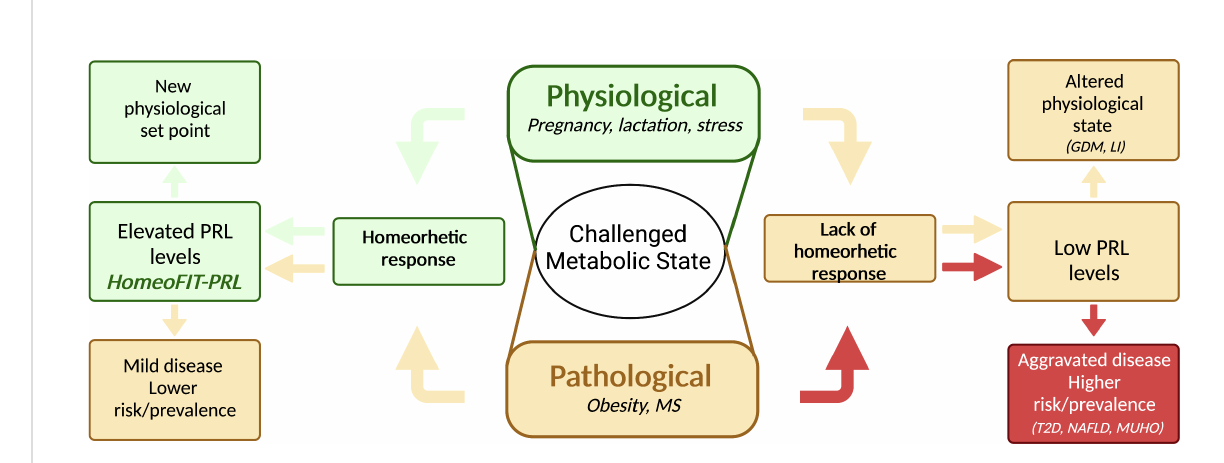
FIGURE 1 Elevated prolactin levels are part of a homeorhetic response upon metabolic challenges. A challenged metabolic state can be either physiological or pathological; in both cases a homeorhetic response includes elevated prolactin (PRL) levels, allowing a series of metabolic adaptations to deal with the physio-pathological demand. In a physiological challenge, such as pregnancy, lactation, or stress, this response leads to a new physiological set point (green arrows), whereas in a pathological challenge, such as obesity, it leads to a milder disease or protection from disease risk (yellow arrows, left side of fi gure). If the homeorhetic response fails, PRL levels do not rise and remain low instead, leading to altered physiological states (i.e., gestational diabetes mellitus, GDM, lactation insuf fi ciency, LI, anxiety) (yellow arrows, right side of fi gure), or to aggravated disease with higher disease risk or prevalence (red arrows, right side of fi gure). MS, metabolic syndrome, T2D, type 2 diabetes, NAFLD, non-alcoholic fatty liver disease; MUHO, metabolically unhealthy obesity. Created in